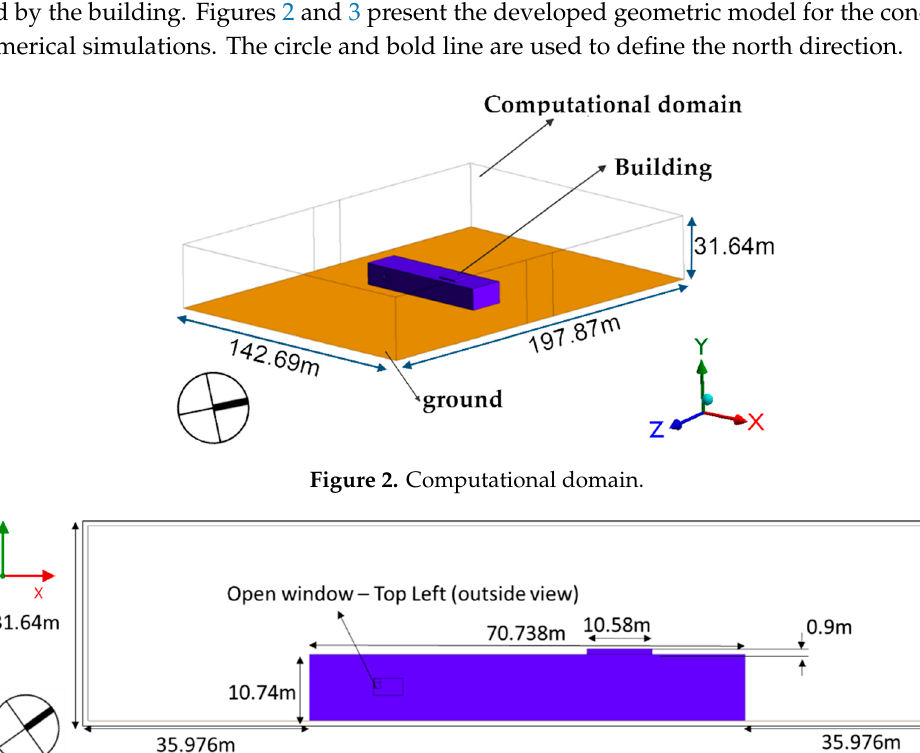
Figure 3. Computational domain (side view).